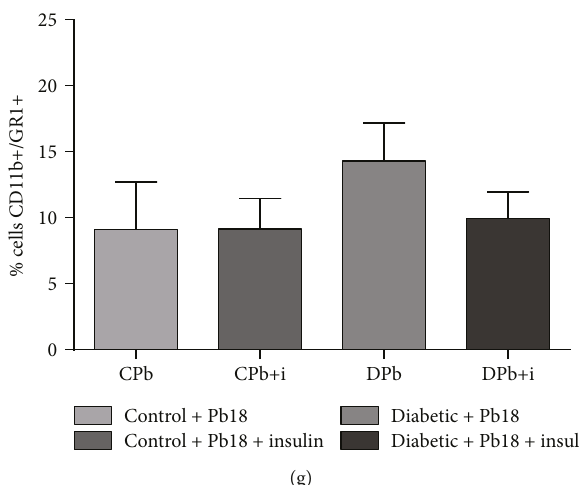
Figure 4: Leukocyte populations in lungs. Mice were rendered diabetic via injection of alloxan (60 mg/kg i.v.) and infected with P. brasiliensis (1 × 10 6 cells i.t.). Lung samples were obtained 55 days after alloxan injection and 45 days after the incubation period. Five animals were used for each group. Values are the means ± SEM. ∗ p < 0 05 ; ∗∗ p < 0 01 ; ∗∗∗ p < 0 001